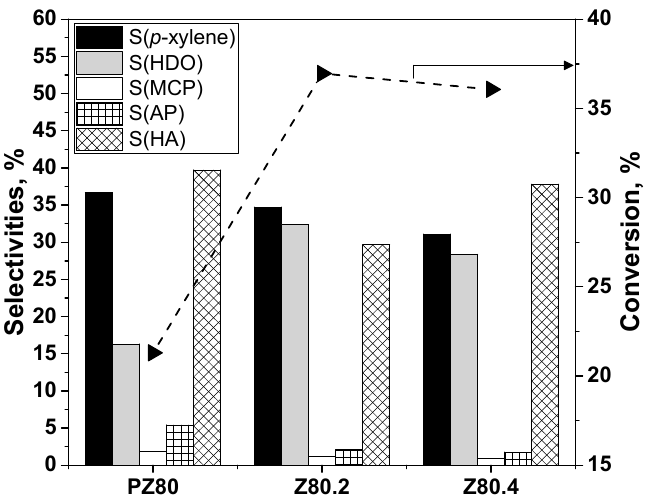
Figure 8. Conversion (X, symbol + line) and selectivity (S, columns) values for untreated and treated Z30. Conversion (triangle), S( p -xylene) (black), S(2,5-hexanedione) (HDO, grey), S(3-methyl-2-cyclopentenone) (MCP, white), S(alkylated products) (AP, square pattern), and S(higher aromatics) (HA, diagonal pattern). Reaction conditions: 180 °C, 40 bar total pressure (pressurised at 180 °C), 5.5 mL DMF, 0.45 mL tridecane (internal standard), 16.5 mL hexane, 110 mg catalyst, 20 h. The carbon mass balance was >96.5%, except in case of Z30.2 it was 85%.